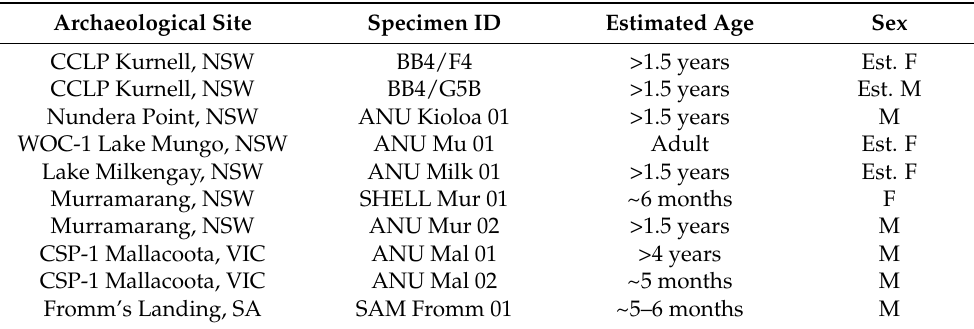
Table 1. Demographic information of archaeological tamed dingoes as reported by Gollan [172]. Sex was mostly determined using the presence/absence of a baculum. Where bones of the pelvic area were not preserved, via metric and non-metric dimorphic traits; some of the latter identifications are therefore best estimates. Highly incomplete specimens for which reasonable assessment was impossible were omitted. Locations of sites are shown in Figure